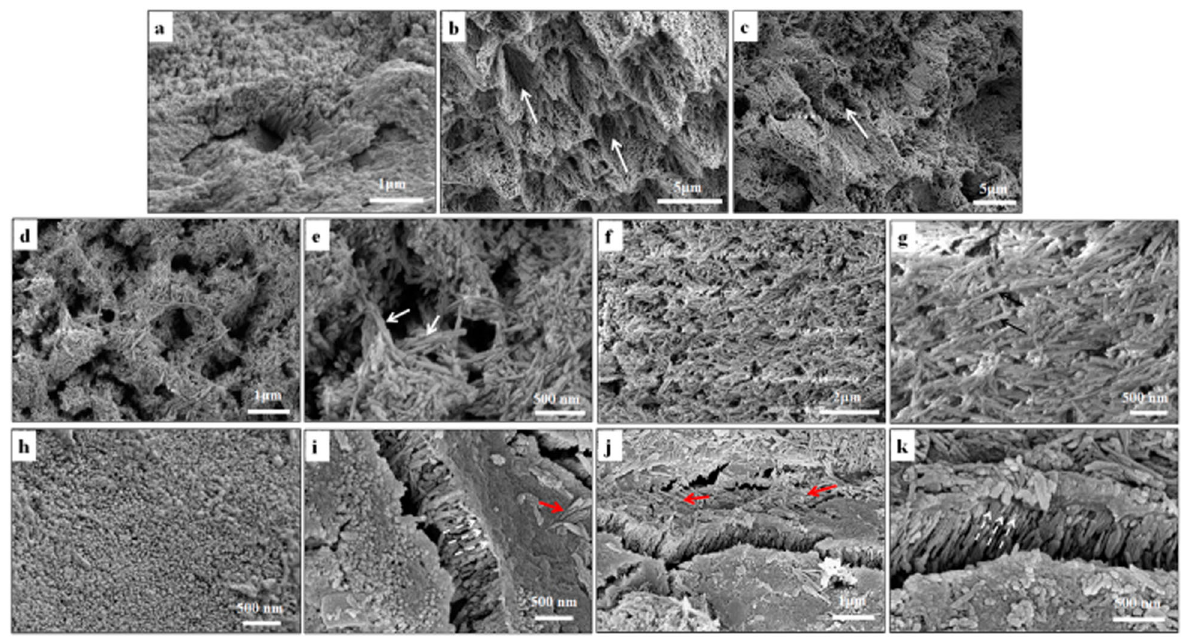
Fig. 6 Restoration of the complicated structure of enamel by CMC- ALN/ACP-Gly. SEM results showing the surface morphology of normal enamel in ( a ). The surface morphologies of demineralized enamel ( b, c ); remineralised enamel with CMC/ACP nanocomplexes ( d, e ); remineralised enamel with CMC-ALN/ACP nanocomplexes ( f, g ); remineralised enamel with combination of CMC-ALN/ACP